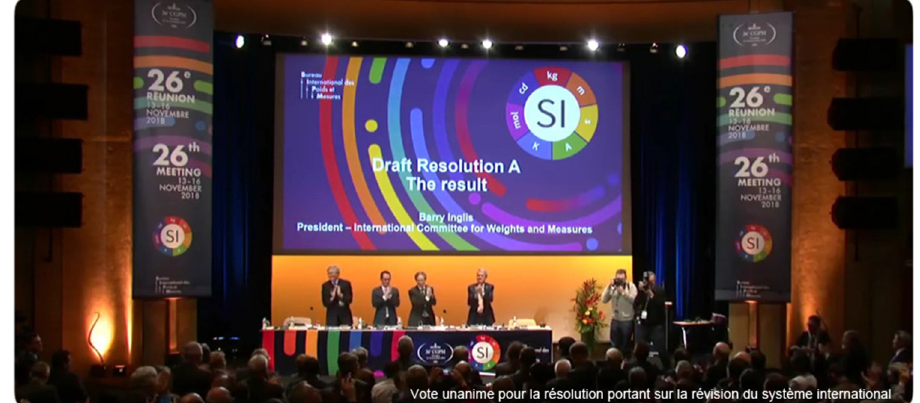
Fig. 8. View of unanimous fi nal voting in favour of Resolution A at 26th CPGM,